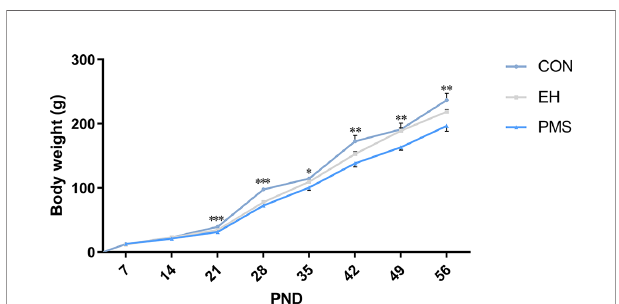
FIGURE 2 | Body weight of offspring rats during experimental procedure. Data are presented as the mean body weight of the pup in each stage. Body weight differences in the control group and EH group and PMS group (CON, EH, PMS). Points represent mean ± SEM, (n=11 rats per group). *p < 0.05, **p < 0.01, ***p